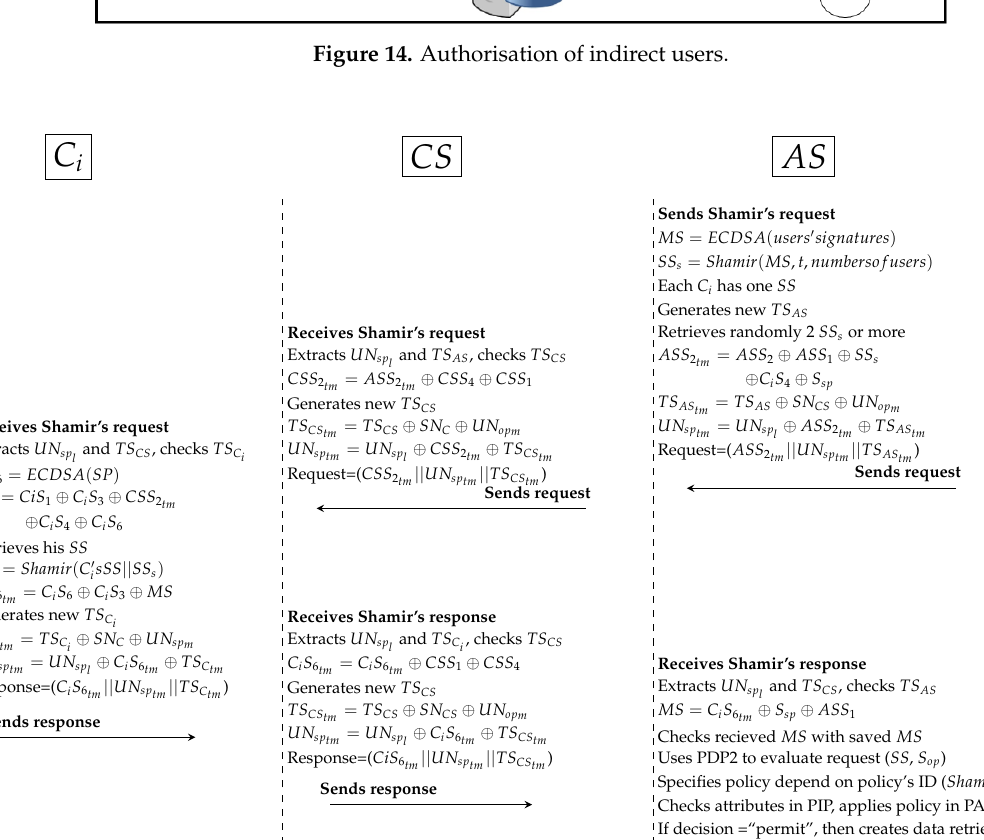
Figure 15. Protocol of PAX model for indirect